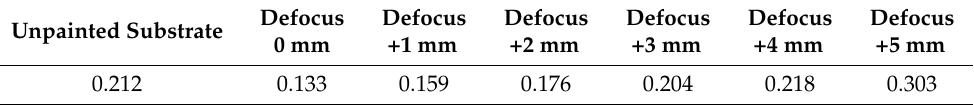
Figure 10. Absorbance of samples laser treated in inert atmosphere and unpainted substrate. Table 6. Absorbance of samples laser treated in inert atmosphere at wavelength 1064